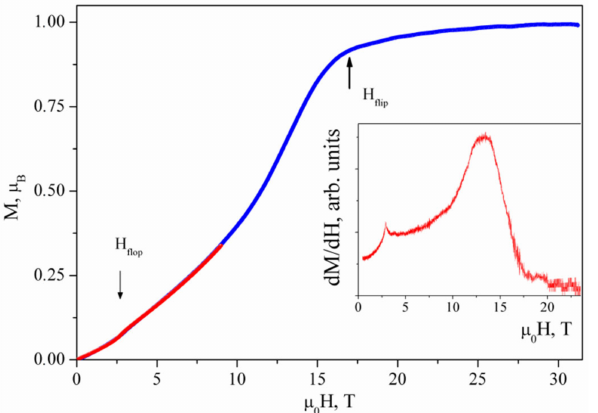
Figure 3. Field dependence of magnetization M in PbCu(SeO 4 )(OH) 2 in a pulsed magnetic field at T = 2.4 K normalized by measurements in the static magnetic field. Inset: dM / dH curve. The temperature dependence of specific heat C p in PbCu(SeO 4 )(OH) 2 is shown in Figure 4. The C p ( T ) curve evidences the presence of a sharp λ -type anomaly at T N = 4.3 K characteristic to the second-order phase transition. At 200 K, which is the upper limit of measurements, the value of specific heat is still far from the thermodynamic limit, 3 Rn = 275 J/mol K, where R is the universal gas constant and n is the number of atoms per formula unit. Under an external magnetic field, this anomaly shifts to lower temperatures, as shown in the inset to Figure 4. In the zero field, the peak is preceded by a pre-transition region, which is strongly suppressed by the magnetic field. It makes the anomaly in strong fields more pronounced, i.e., the ∆ C p at the transition point